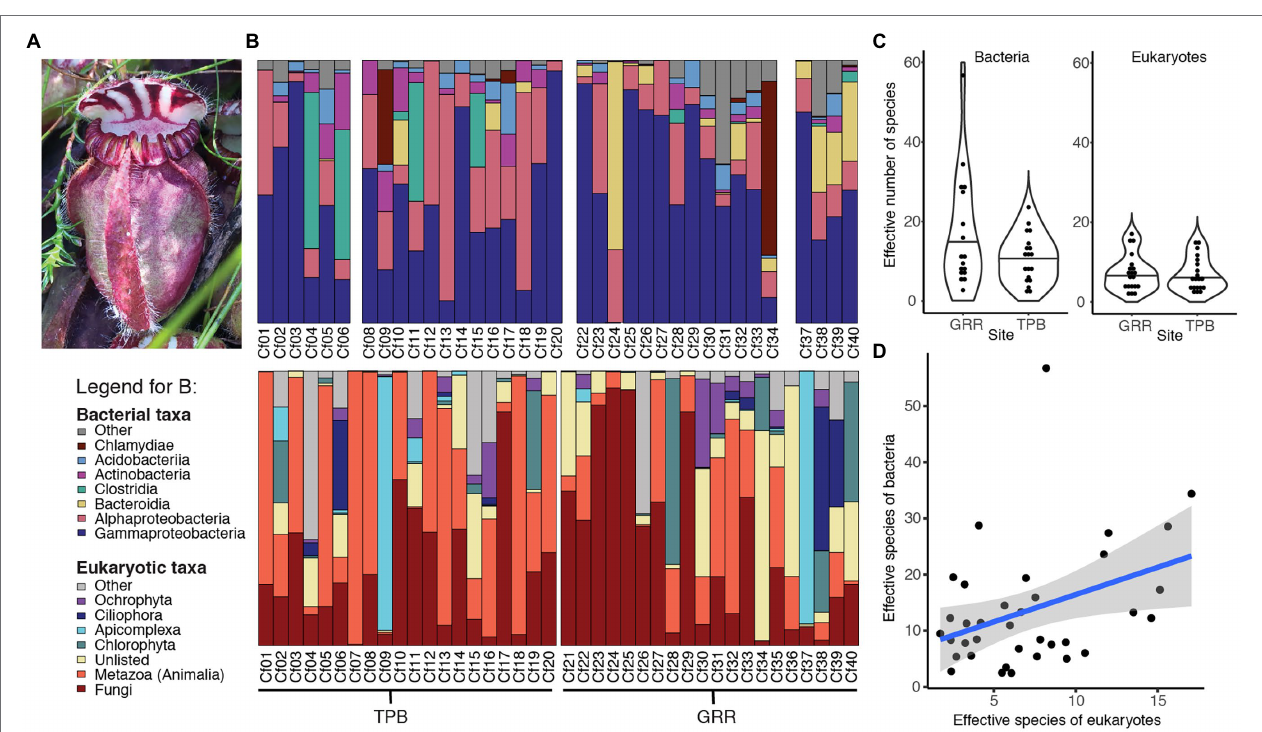
FIGURE 1 | Characterizing Cephalotus follicularis -associated communities. (A) Image of C. follicularis pitcher in its natural habitat (Photo credit: L.S. Bittleston). (B) Relative abundances of the most common bacterial (top) and eukaryotic (bottom) taxa across our samples. The first 20 were from site Two Peoples Bay (TPB) and the second set from Gull Rock Road (GRR). Some bacterial samples did not sequence well (Cf07, 21, 35, and 36); those columns are left blank. (C) Richness, measured as effective number of species [the exponential of Shannon diversity of the amplicon sequence variants (ASVs)] by site for bacteria (left) and eukaryotes (right). (D) Bacterial and eukaryotic richness (effective numbers of species) are correlated.